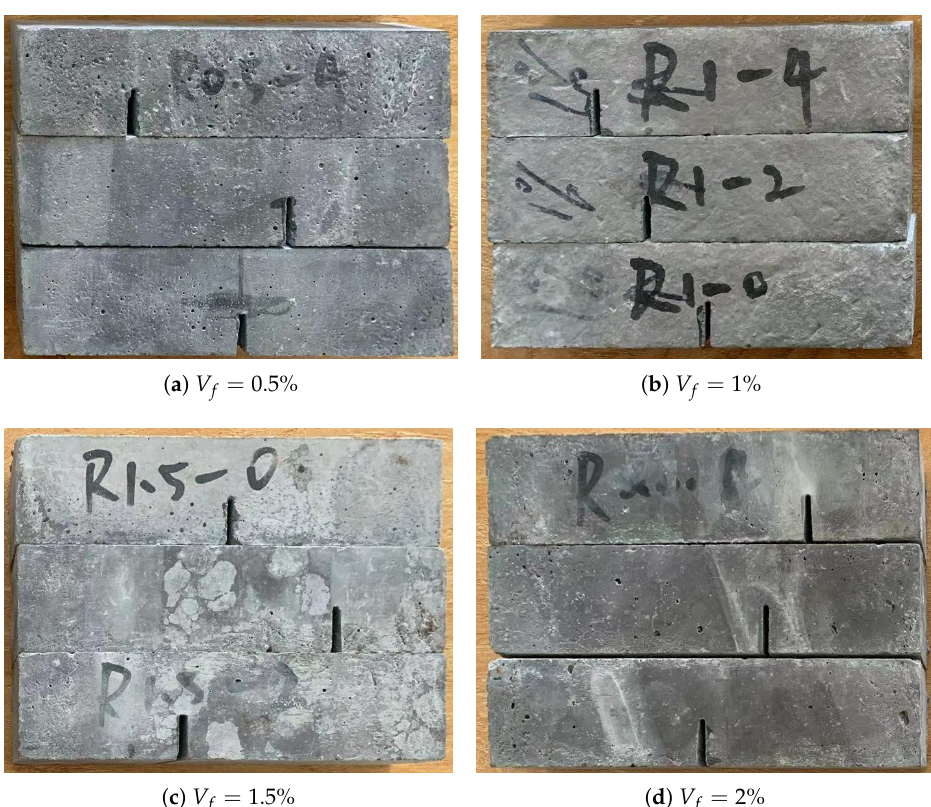
Figure 2. Photos of the notched UHPC-PVA beam specimens used for the three-point bending test. The tests were carried out on a electromechanical compression testing machine (WAW1000) shown in Figure 3a. The loading conditions are described as in Figures 1 and 3a. The loading head forces the upper center of the beam specimens to gradually move downward at a rate of ∆ v = 2 × 10 − 4 mm/s until the crack propagates and penetrates the specimens.